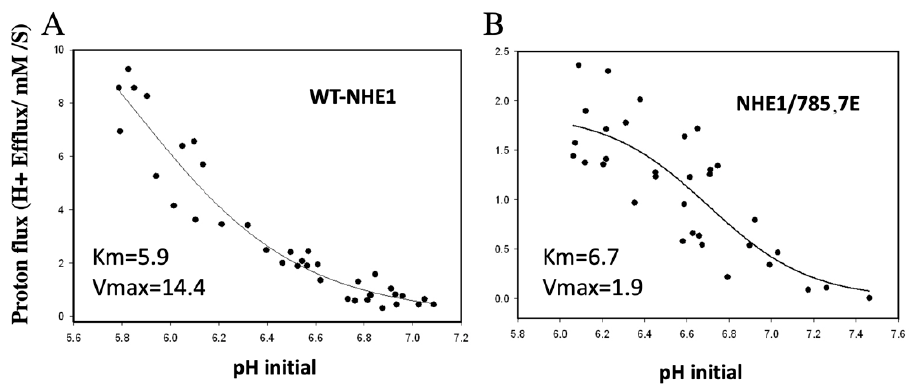
Figure 3. Dependence of proton efflux on intracellular pH in NHE1 expressing AP1 cells. Cells were incubated with varying amounts of ammonium chloride that was removed to induce different de- grees of acid load. Recovery was determined in Na + -containing buffer 135 mM. Proton efflux was calculated from the initial rate of recovery and the buffering capacity as described in Materials and Methods. WT, wild type, mutants 785E, 787E where indicated. ( A ) Proton flux wild type NHE1 containing cells and ( B ) proton flux of 785E, 787E NHE1-mutant containing cells. To further characterize the effect of mutations to amino acids 785 and 787 on the NHE1 carboxyl-terminal region, we expressed and purified the C-terminal 182 amino ac- ids of the protein with and without the phosphomimetic mutations. We then treated the proteins with varying amounts of trypsin and examined the time course of degradation and protein fragments produced. The results are shown in Figure 4A. Without added trypsin, the wild-type protein ran as a protein band with a molecular weight of approxi- mately 25 kDa. In contrast, the mutant protein had reduced mobility and was approxi- mately 29 kDa in size. The pattern of proteins produced with trypsin treatment varied between the two proteins. Most notable was a protein with an apparent molecular weight